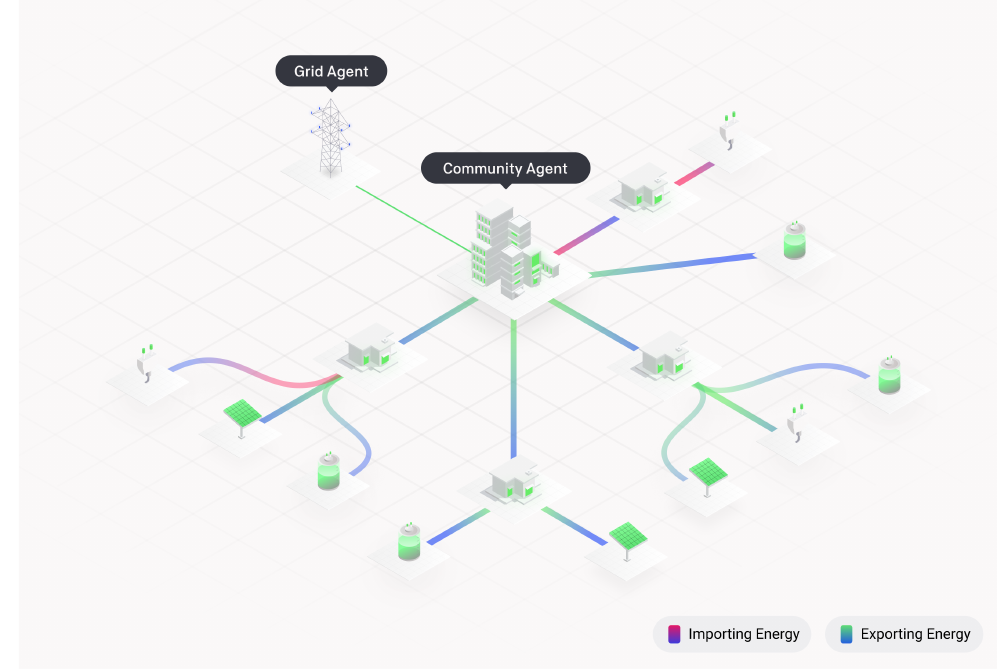
Figure 3. Single-layer, hierarchical, agent-based